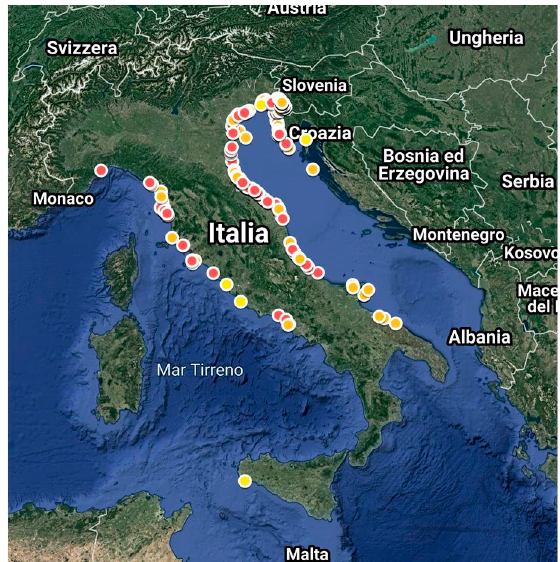
Figure 6. Map of sighting locations of M. leidyi and reported abundance range (yellow dot: 1 ind. m − 2 ; orange dot: 1–10 ind. m − 2 ; red dot: >20 ind. m − 2 ).